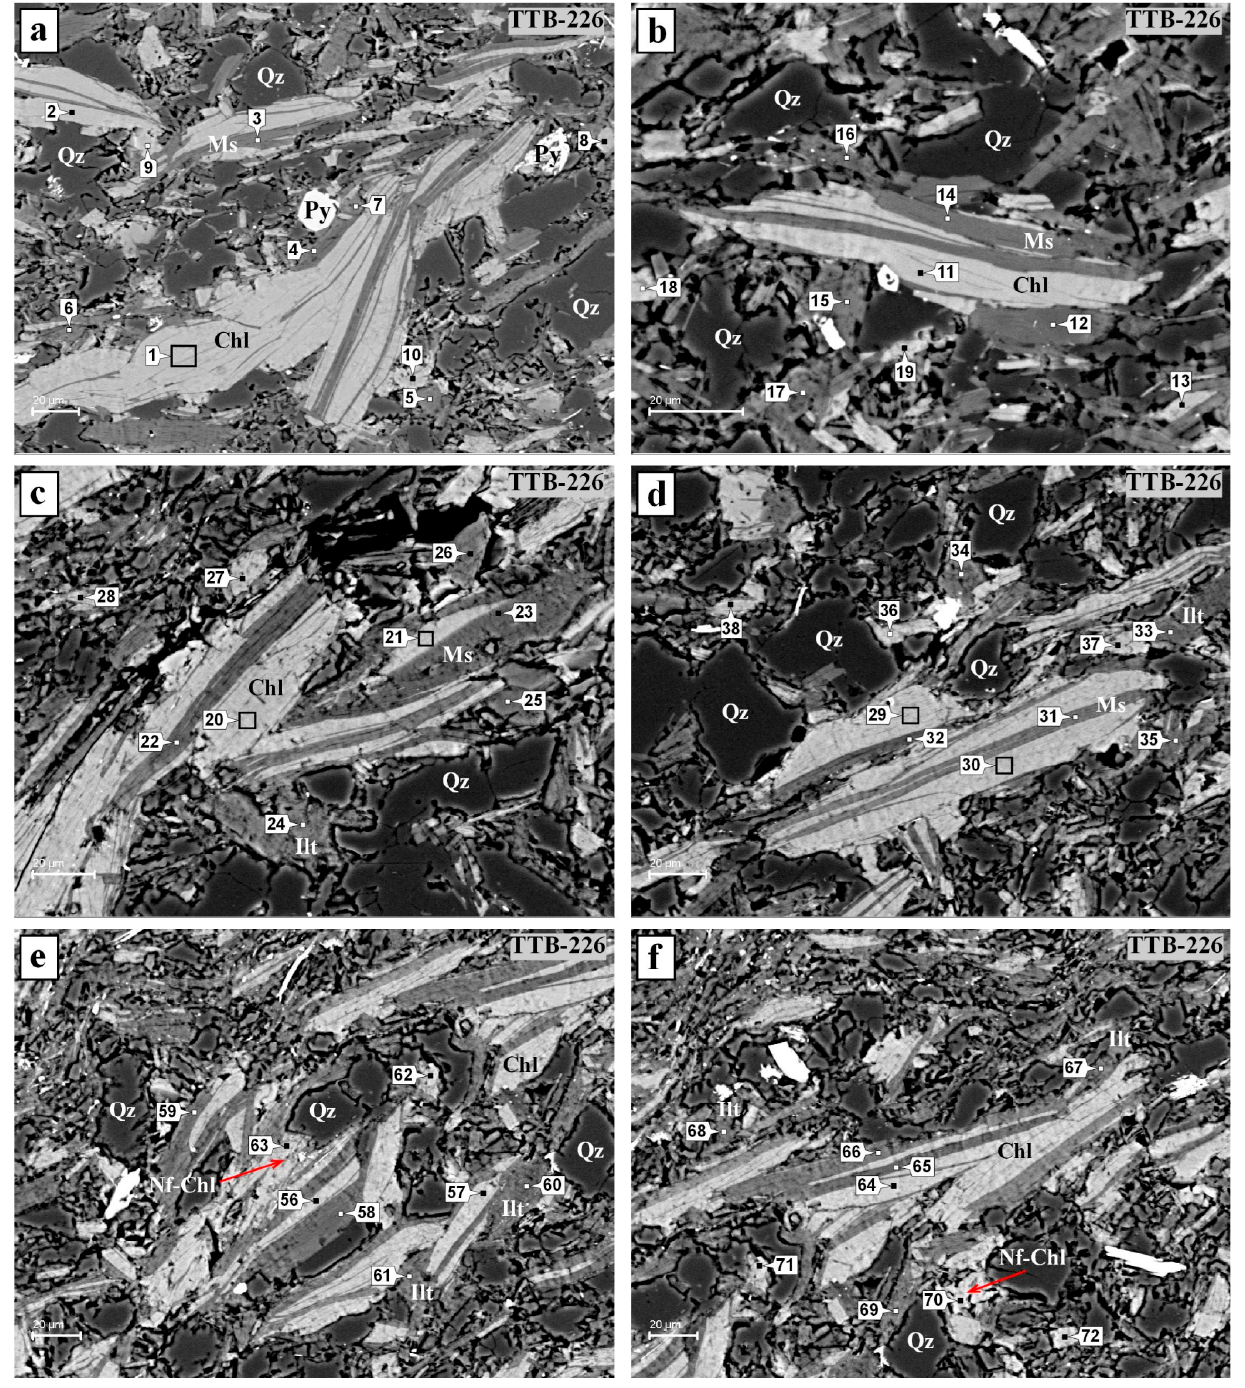
Figure 5. SEM-BSE photomicrographs of the early Ordovician slate with locations of some analyzed points and areas (black rectangulars). ( a , b ) Coarse-grained tectonically disturbed chlorite-rich CMS which parallel the bedding planes within the slightly oriented groundmass, ( c , d ) Chlorite-rich CMS within the quartz, neoformed illite (Ilt) and chlorite (Nf-Chl) bearing groundmass, ( e , f ) Muscovite- rich CMS with long axes were almost parallel to bedding planes and widespread occurrences of neoformed illites and chlorites in the pores of the groundmass. Chl = Chlorite, Nf-Chl: Neoformed chlorite, Ilt = Illite, Ms = Muscovite, Py = Pyrite, Qz =